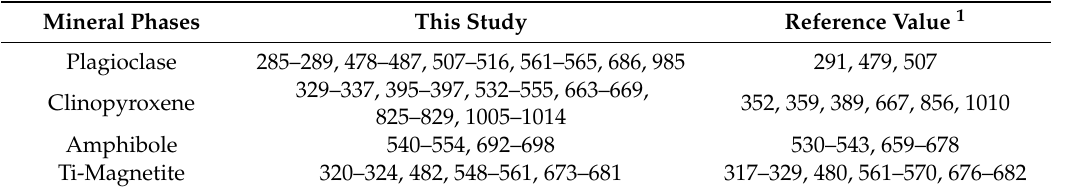
Table 2. Range of Raman spectrum of representative mineral phases in this study and representative Raman spectrum from RRUFF database (cm –1 ).